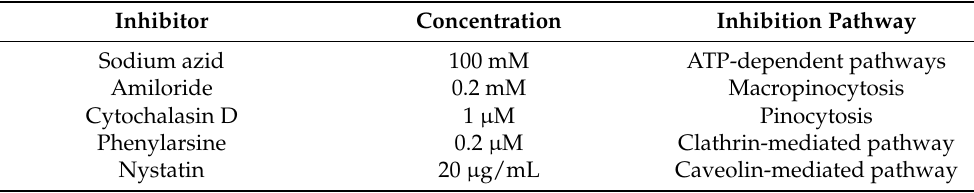
Table 3. Endocytosis inhibitors and their respective target